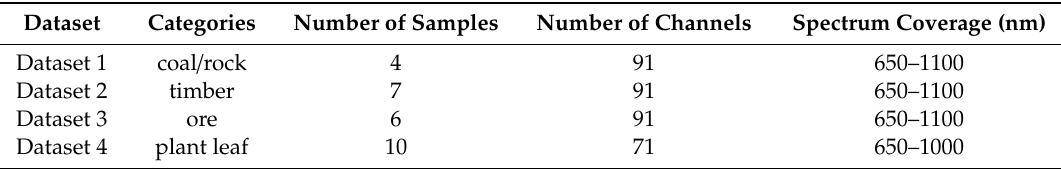
Table 2. Dataset